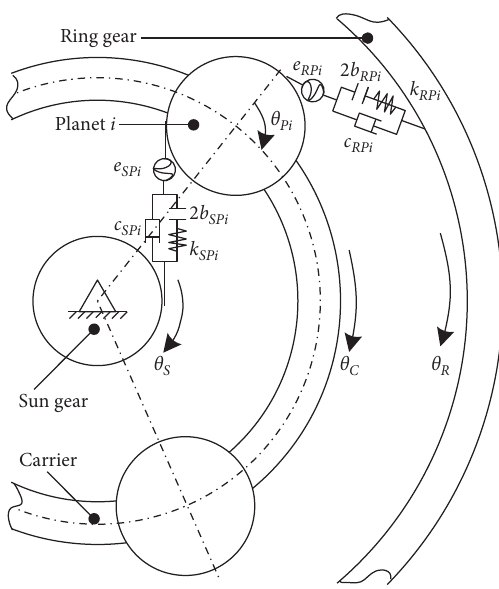
Figure 2: Schematic representation of the power-split PGT.